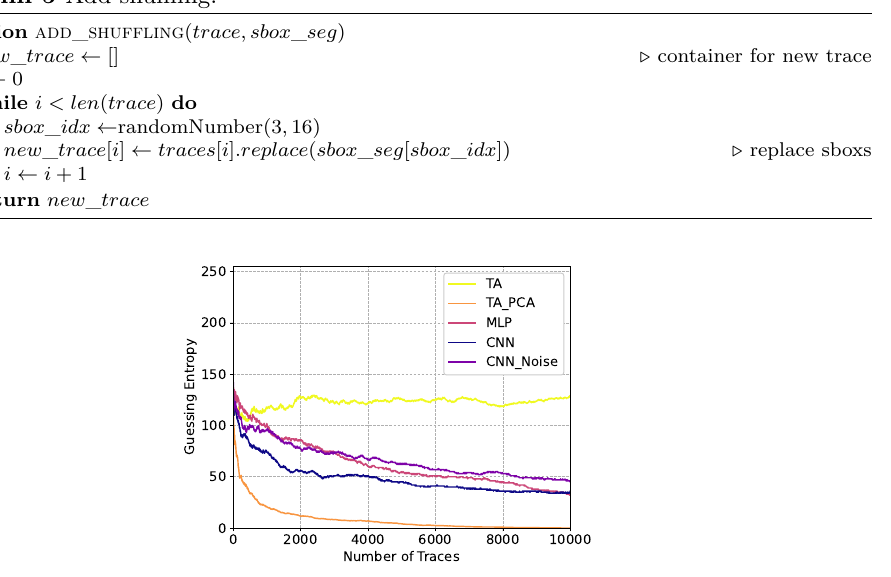
Algorithm 5 Add shuffling.